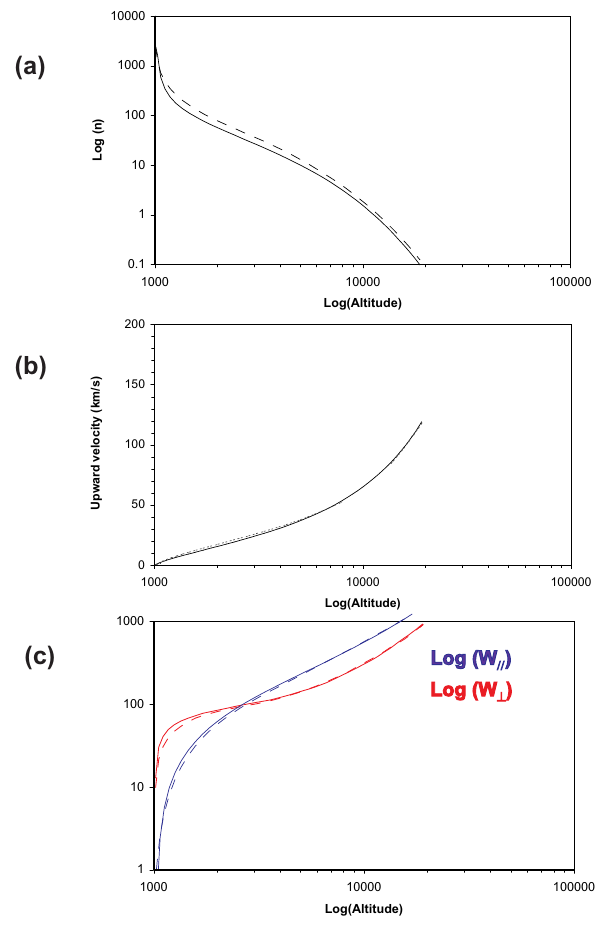
Fig. 6. Evolution of O + moments along the poleward heating boundary: ( a ) density, ( b ) upward mean velocity, ( c ) perpendic- ular (red) and parallel (blue) mean energies. The solid and dashed curves are associated with a source distribution without temperature and with a parallel temperature of 0.3eV,